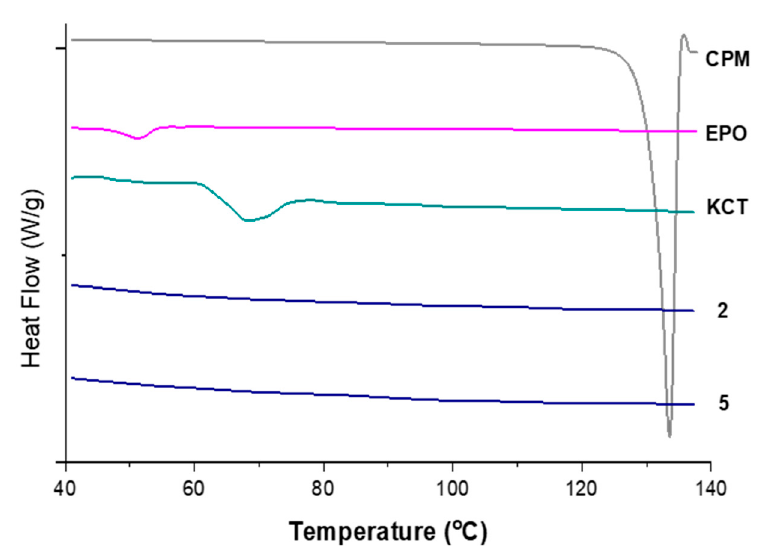
Figure 8. DSC thermograms of pure CPM, raw E-EPO, KCT, and co-axial systems 2 and 5, which contains both polymers as well as the drug. Exo up.